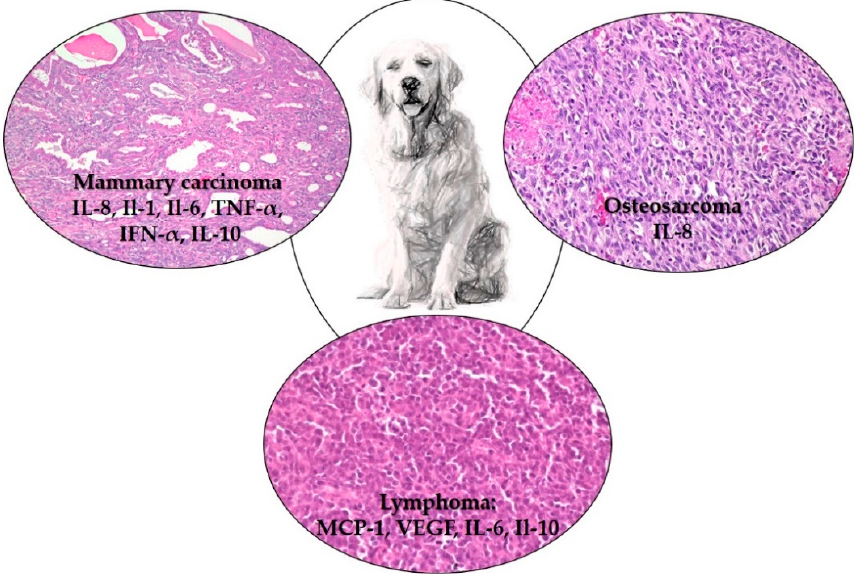
Figure 1. Cytokines with a potential diagnostic application in canine mammary carcinoma, osteosarcoma and lymphoma. Cytokines have been selected based on the literature [10,15–19,21,46]. All the cytokines are increased in the tumours included in the